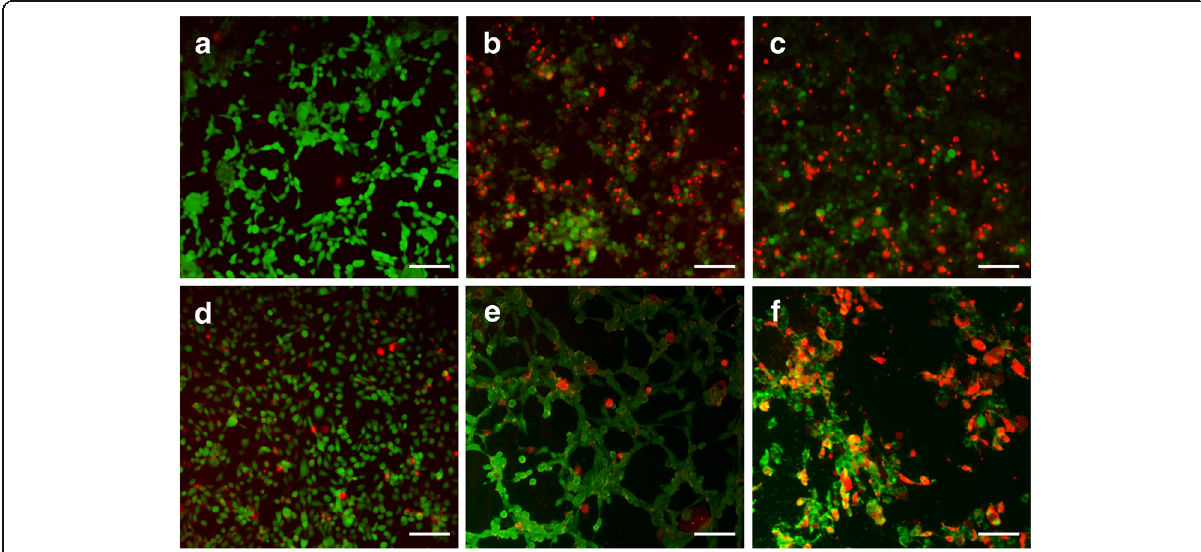
Fig. 7 Fluorescent images of cytotoxicity in NIH3T3 cells with a untreated, b only β -LP, c β -LP/PNIPAM-co-AAc5, and d β -LP/PNIPAM-co-AAc20 treatment for 3 h at pH 7.4, and β -LP/PNIPAM-co-AAc20 treatment for 3 h ( e ) and 6 h ( f ) at pH 8.0. The live and dead cells are stained with calcein AM (green) and ethidium homodimer (red). Scale bars are 100 μ